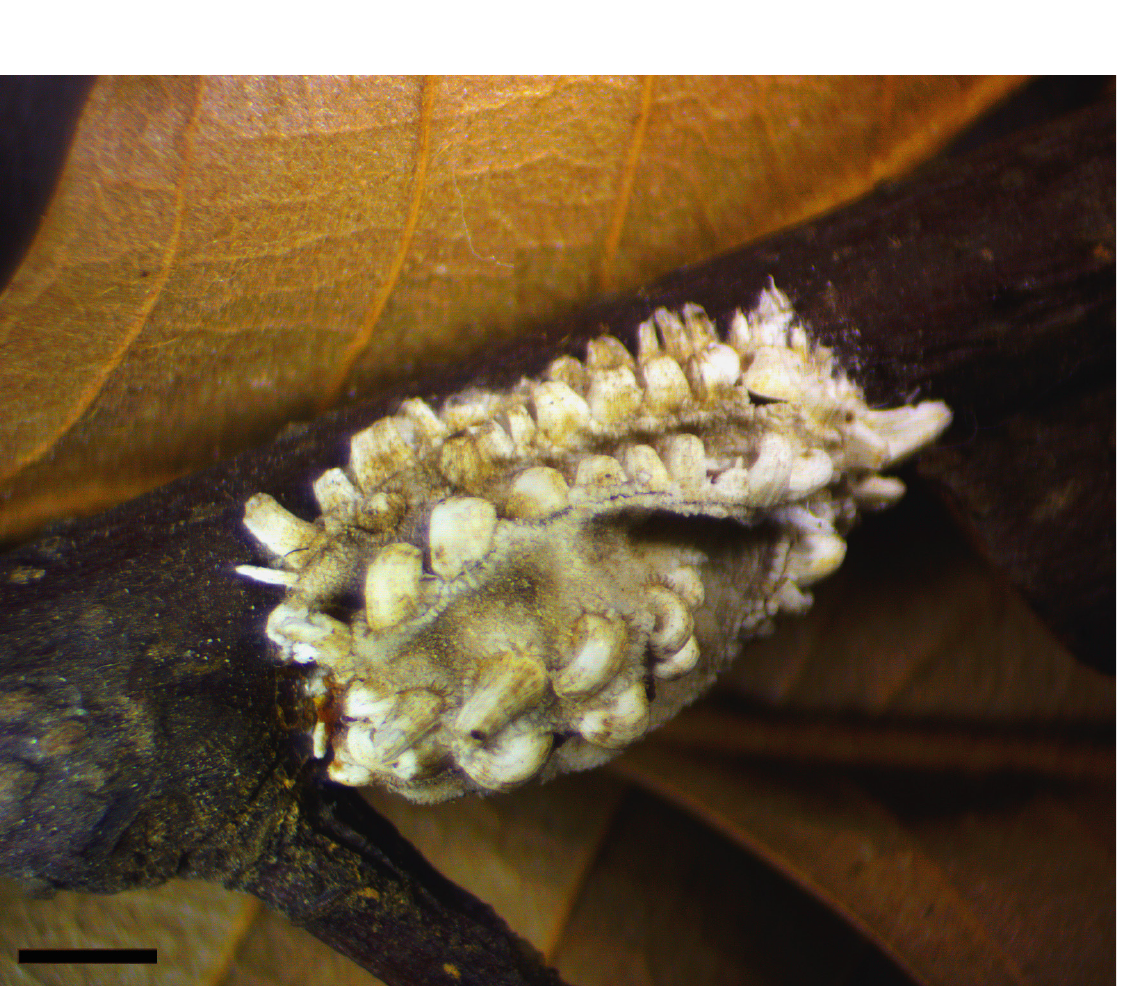
Fig. 1. Gompholopium quercicola gen et sp. nov., paratype, dry ♀ (ZIN RAS, K 1548) on twig of host plant. Scale bar = 1